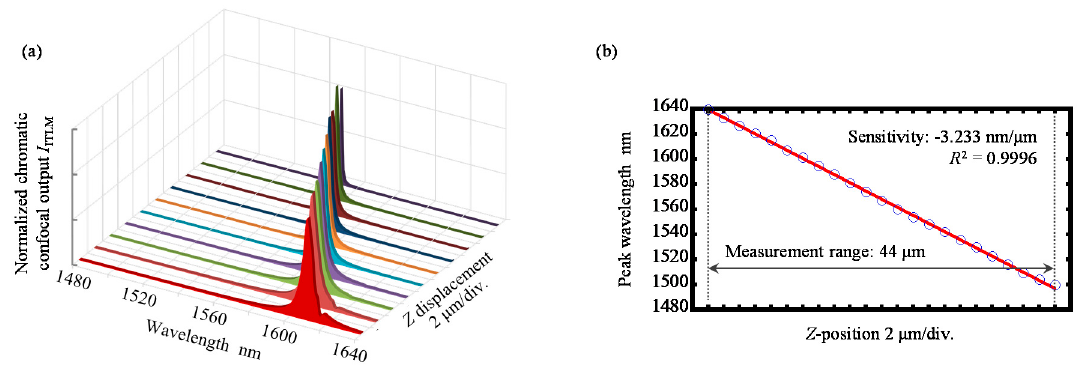
Figure 12. Experimental results of the wavelength-to-displacement encoding in the proposed off-axis differential chromatic confocal probe system. ( a ) Normalized chromatic confocal outputs in the range of 1550–1610 nm obtained at each Z -position; ( b ) variation of the peak wavelength over a range of 46 μ m.